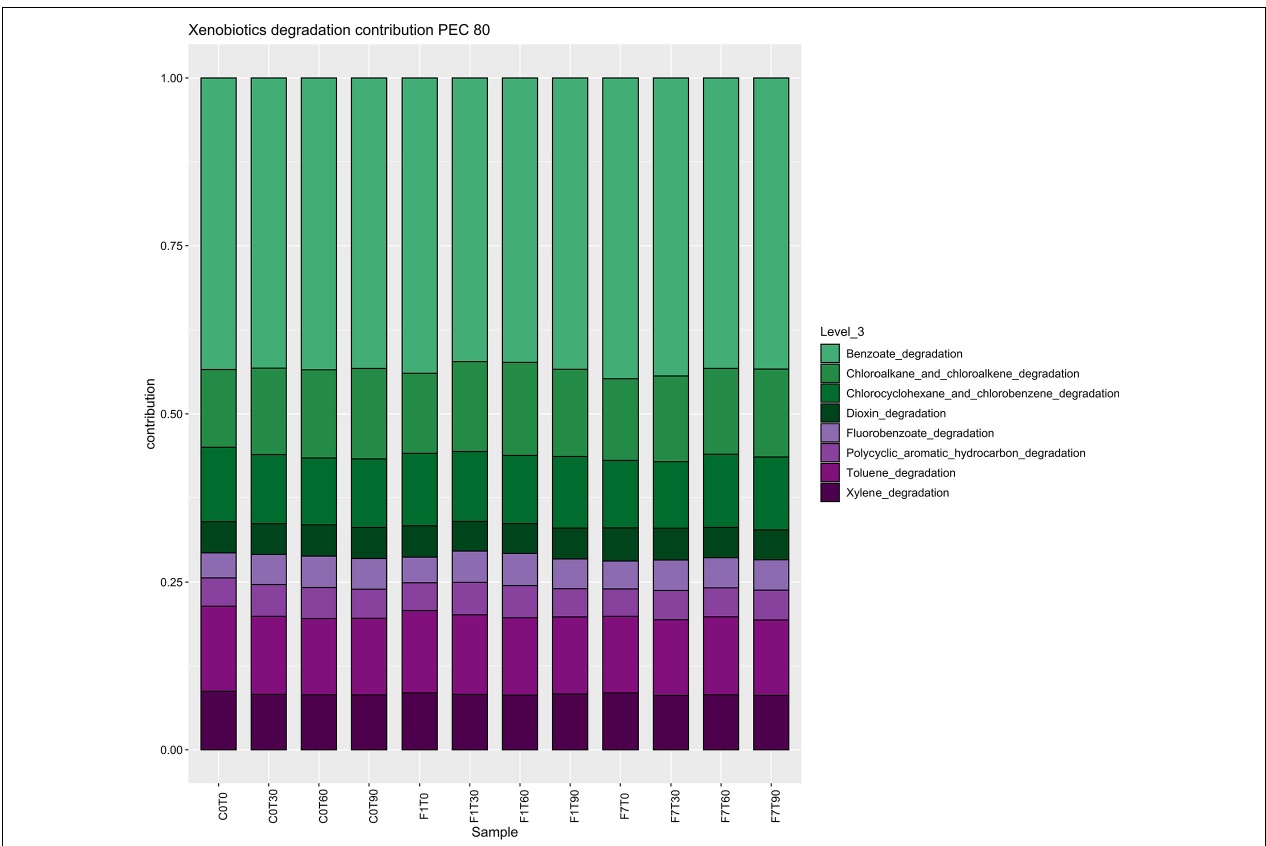
FIGURE 9 | Stacked barplot representing composition of bacterial contributions to xenobiotic degradation pathways, depicted in Figure 8 . Each bar represents the average of three